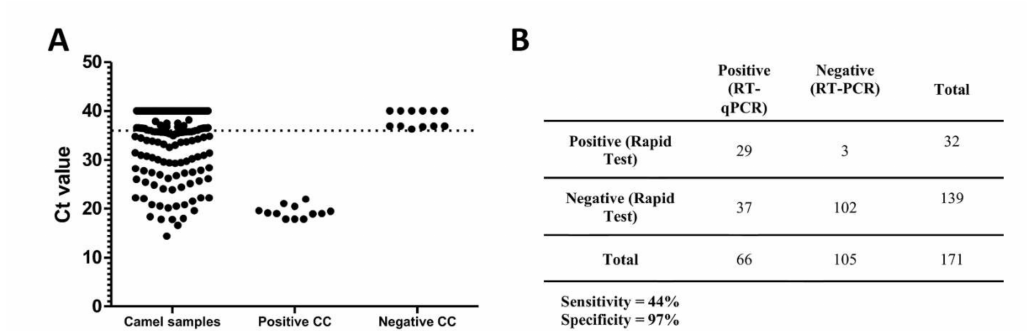
Figure 1. Molecular detection of MERS-CoV in slaughterhouse camels in Riyadh, 2019. ( A ): Camel nasal swab samples tested by RT-PCR ( n = 171) and presented as Ct values. Negative control and positive control samples were tested in this assay. Samples are considered positive if their values is below the dotted line, which represent the cuto ff of the assay. ( B ): A comparison between the RT-PCR and the Rapid test representing the sensitivity and specificity of the Rapid